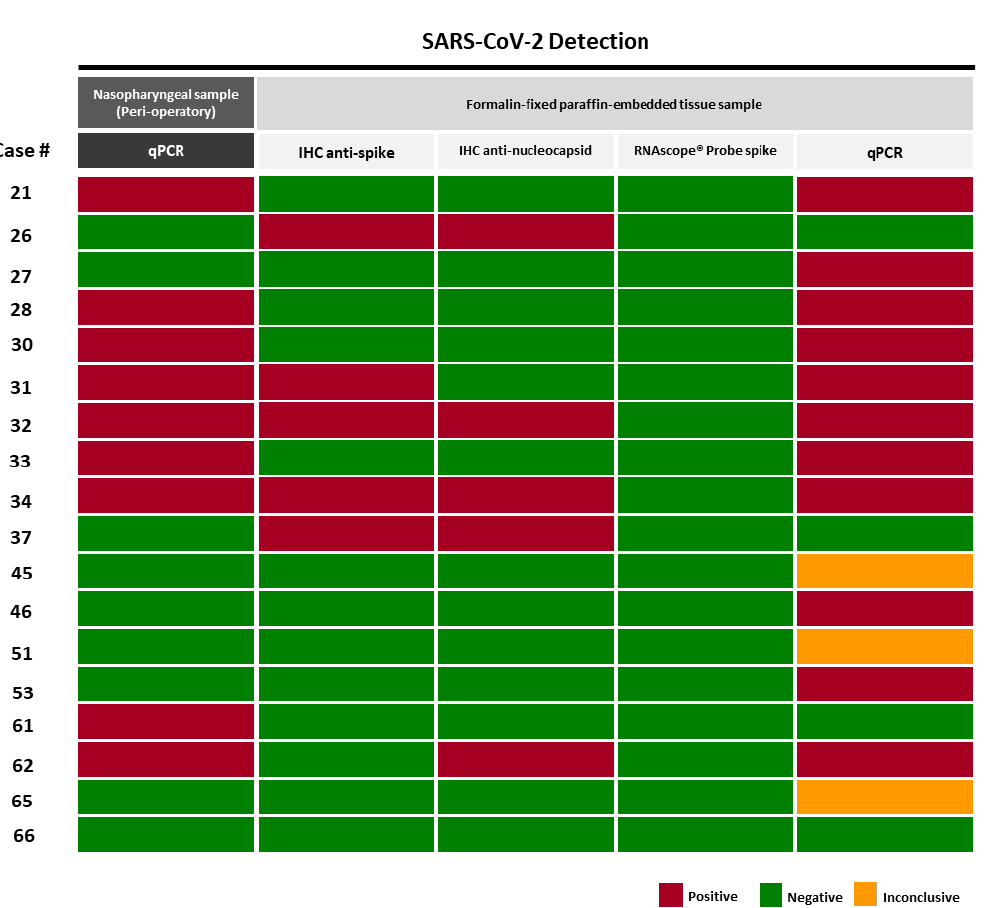
Figure 3. SARS-CoV-2 detection on a colon carcinoma case. Patient no. 32 tested positive for SARS-CoV-2 after sigmoidectomy surgery and we observed staining in the cancer cell with both SARS-CoV-2 antibodies ( A , B ) but not with in situ hybridization (ISH) ( C ). We extracted the RNA from the tumor block; the PCR results were positive. The lower panel shows infected VERO cells used as the positive control for antibodies ( D , E ) and ISH ( F ).